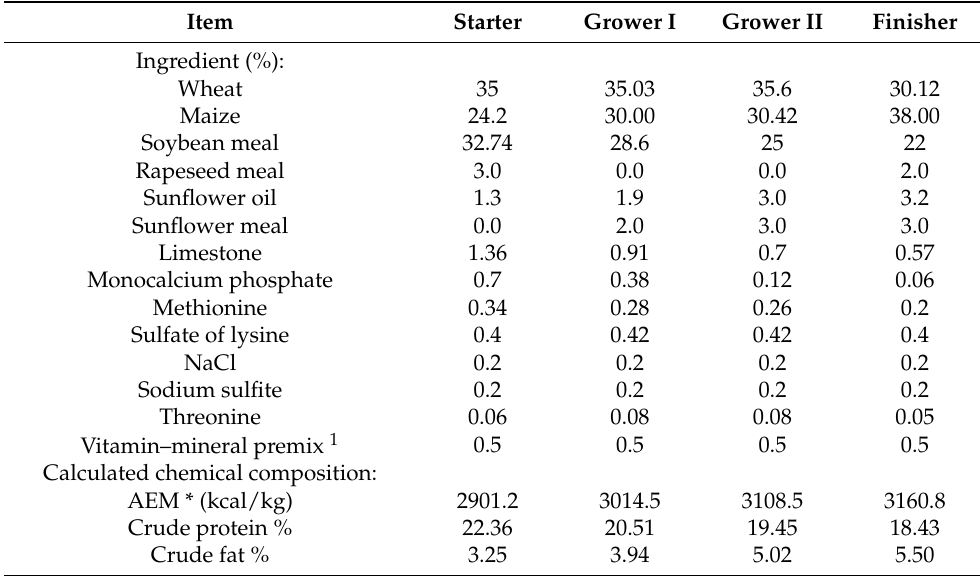
Table 1. Formulation and nutritional composition of the chickens’